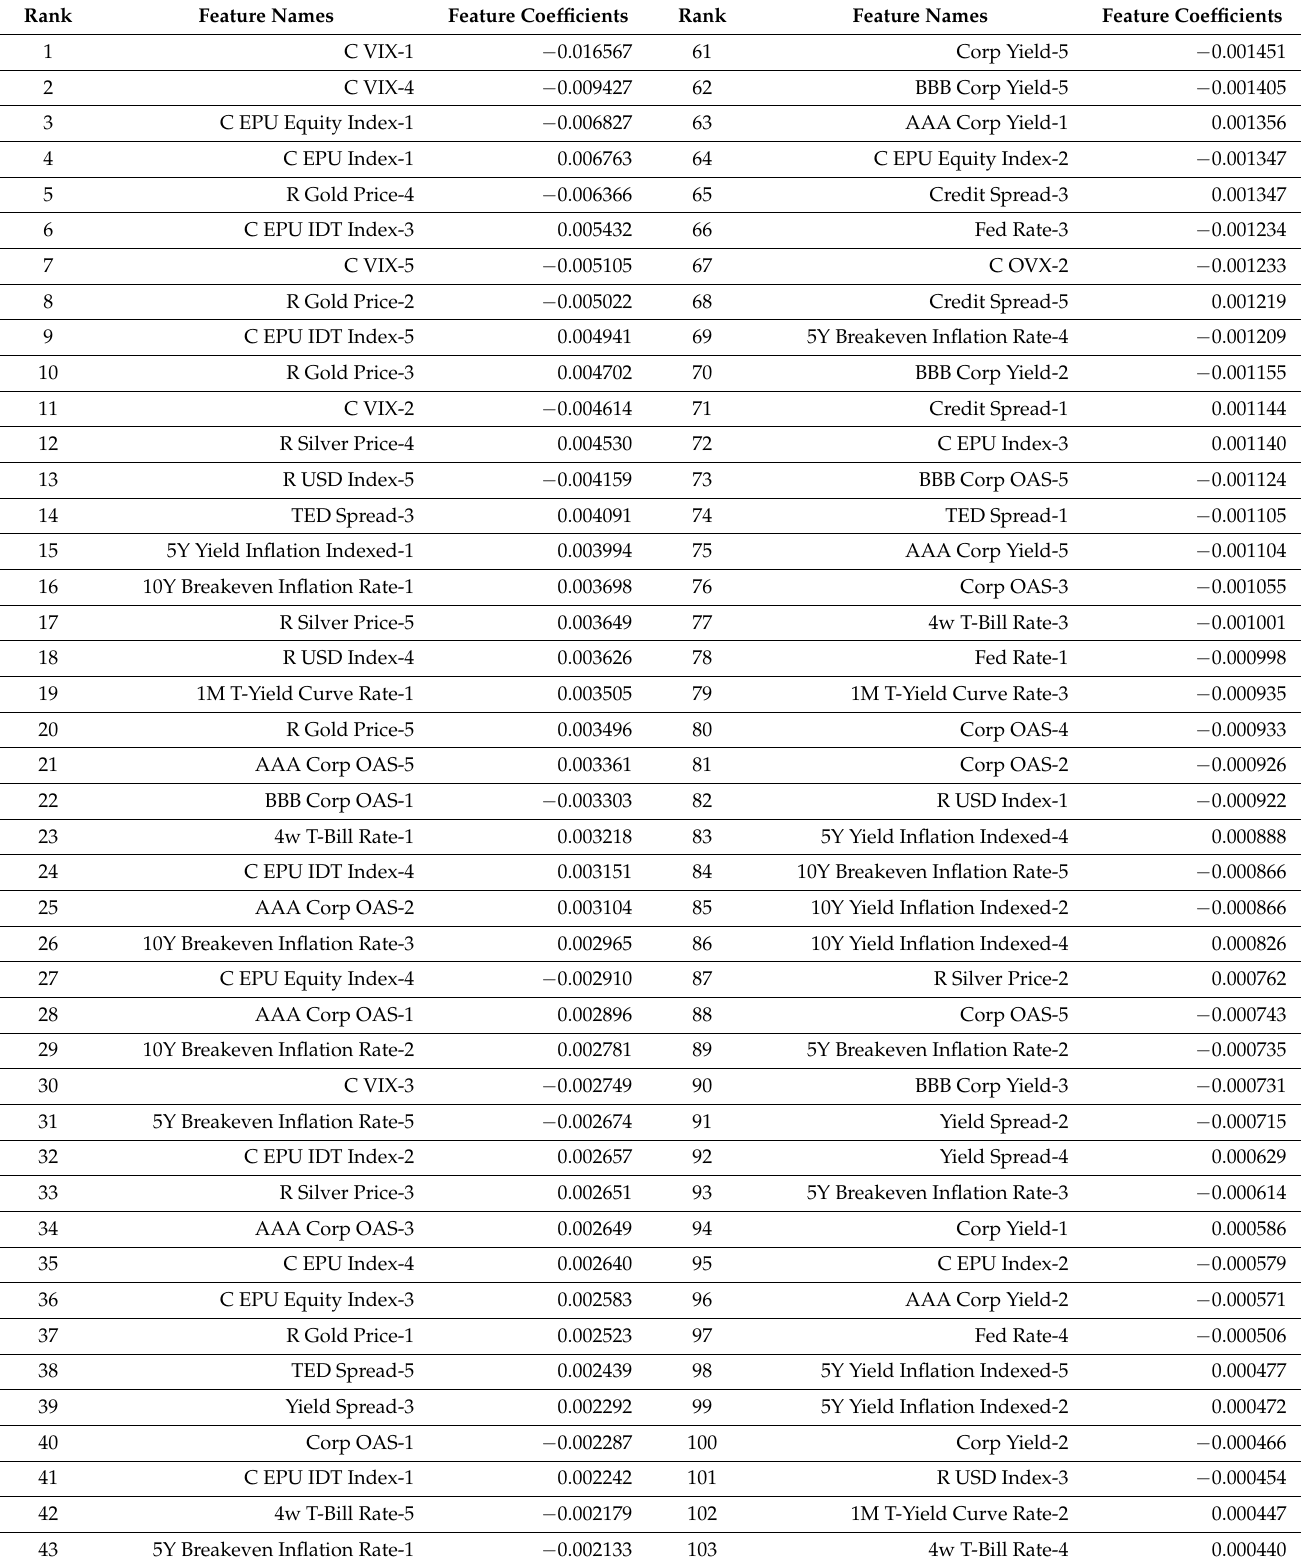
Table A3. Complete list of daily ranked features and their coefficient from Logistic Regression. Numbers are truncated to six decimal